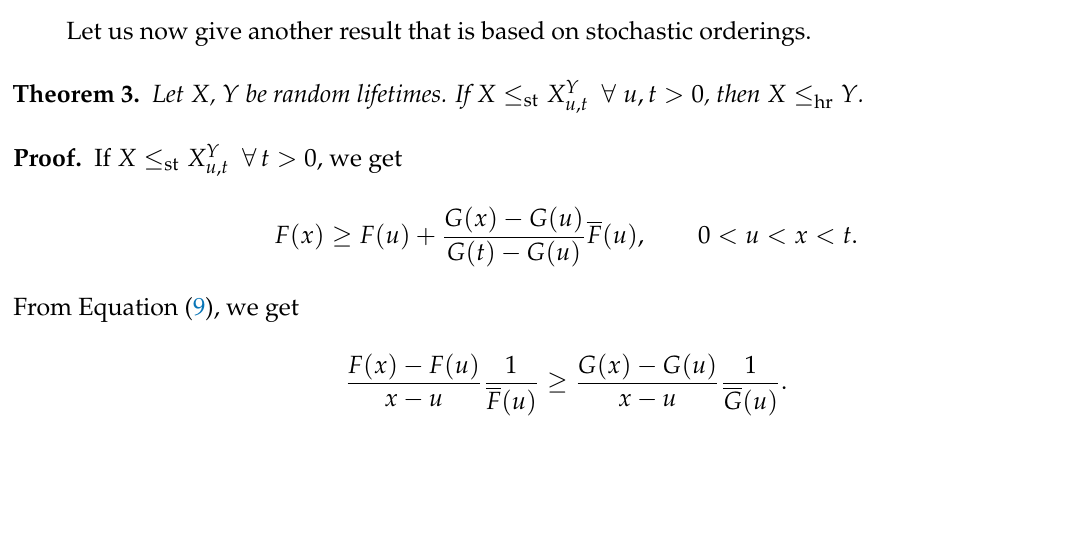
Figure 4. The ratio F ( x ) / F considered in Example 2, for u = 0.6 and t =